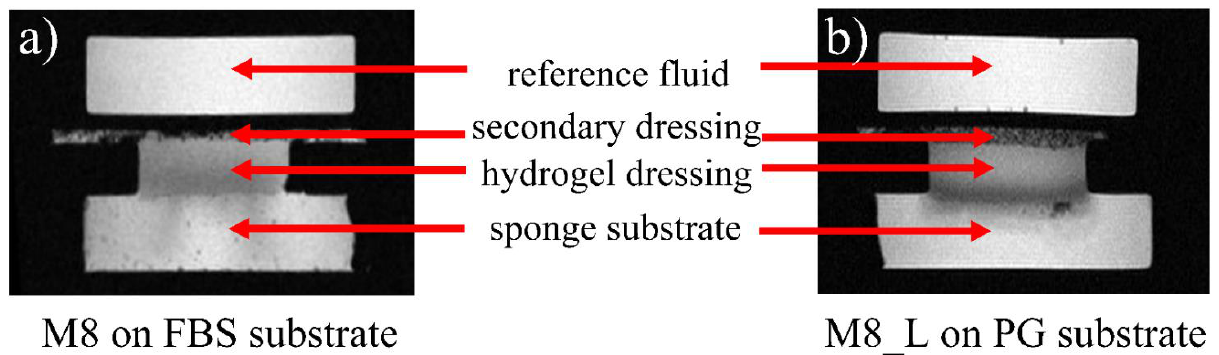
Figure 2. Images obtained at 20th echo (70 ms) at 15 min with MRI MSME sequence for M8 dressing samples on FBS wetted substrate ( a ) and M8_L dressing on PG wetted substrate ( b ).